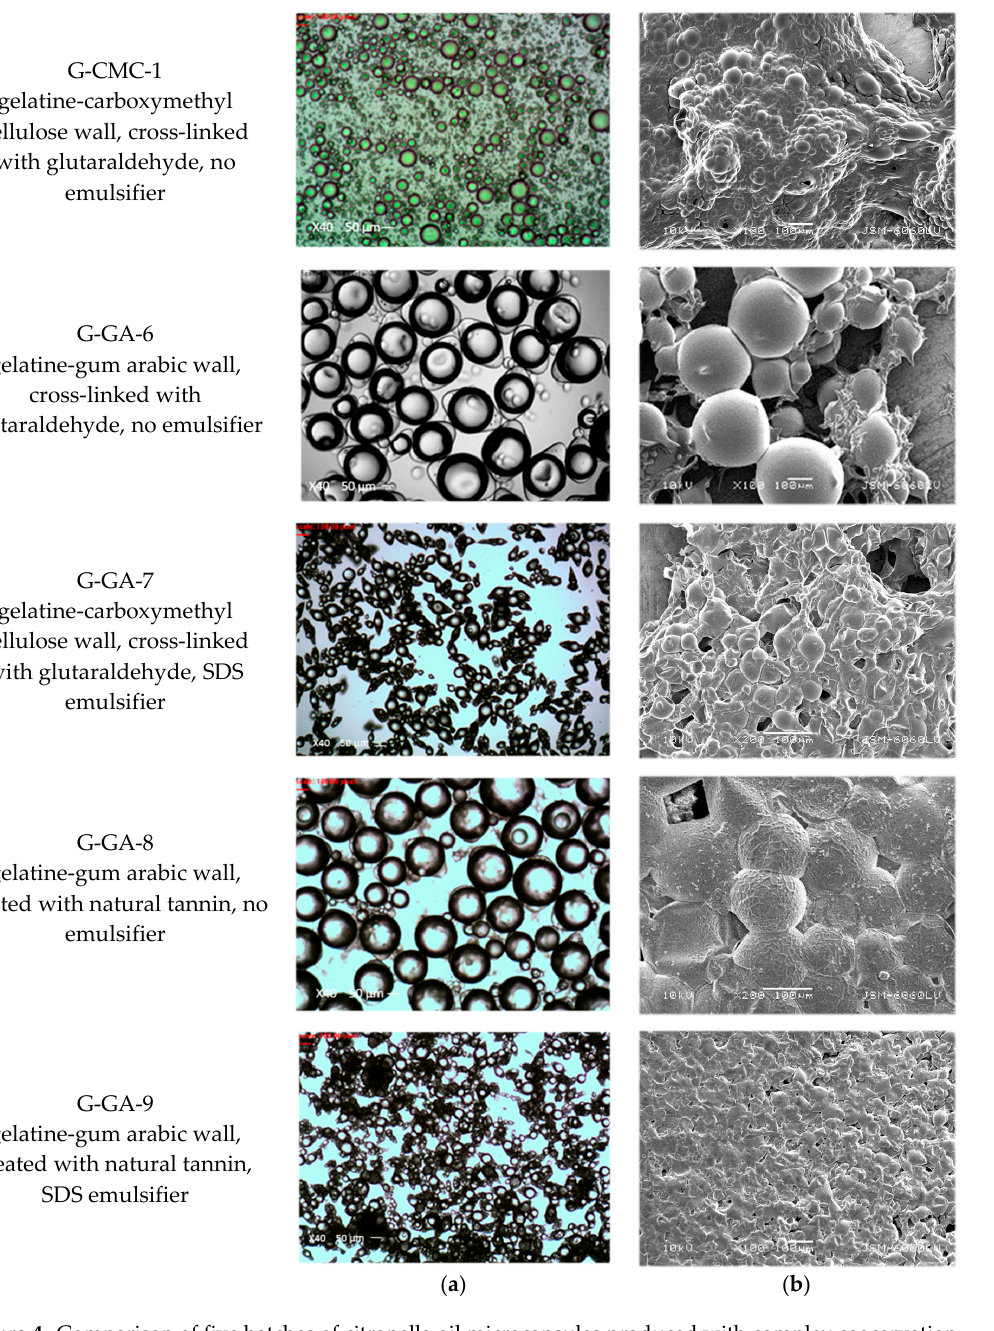
Figure 4. Comparison of five batches of citronella oil microcapsules produced with complex coacervation: ( a ) TLM of aqueous suspension (40×); ( b ) SEM of dry microcapsules (100×, 200×).